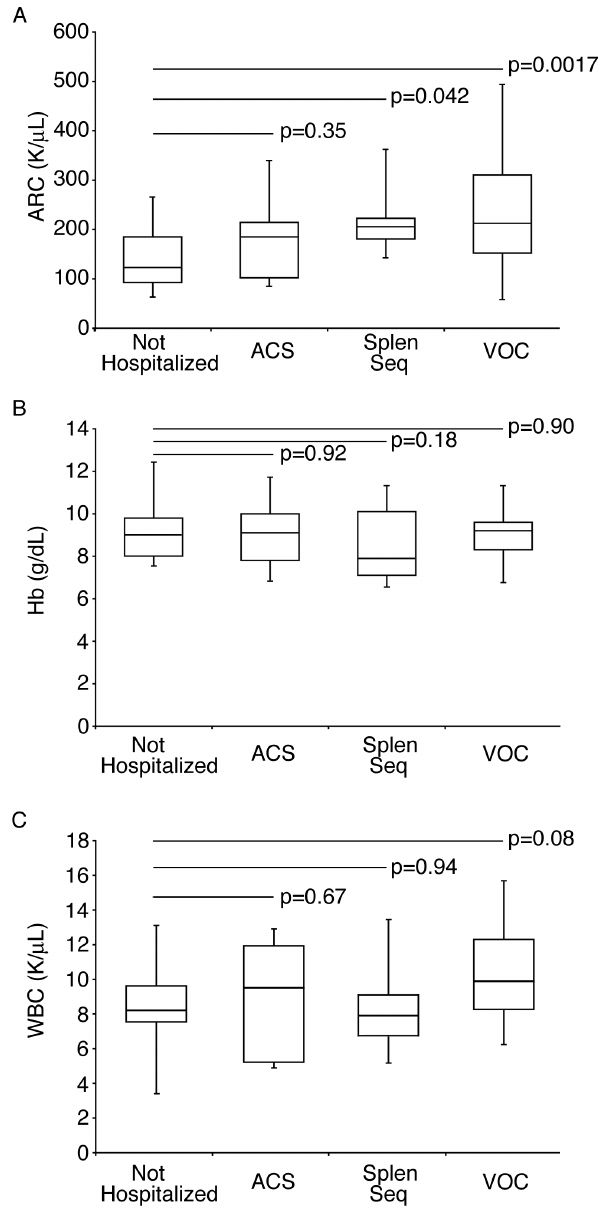
Figure 2. Comparison of absolute reticulocyte counts and blood hemoglobin and white blood cell levels according to early hospitalization. A. Steady state absolute reticulocyte count values measured during early infancy (60–180 days; shown in box and whiskers format) for subjects with no history of hospitalization (No Hosp., n=23) versus subjects who required early hospitalization (before age three years) for each cause of hospitalization [acute chest syndrome (ACS, n=11), splenic sequestration (Splen seq, n=10) and vaso- occlusive crisis (VOC, n=15)]. Equivalent analyses were performed using hemoglobin levels (Panel B) and white blood cell counts (Panel C). Unadjusted significance (p values) of differences from the non- hospitalized group is shown on top of the bars. After adjusting for multiple comparisons, the absolute reticulocyte count for the VOC group remained significantly higher than that for the group with no hospitalizations. ARC, Absolute Reticulocyte Count; Hb, hemoglobin; WBC, White Blood Cell count.